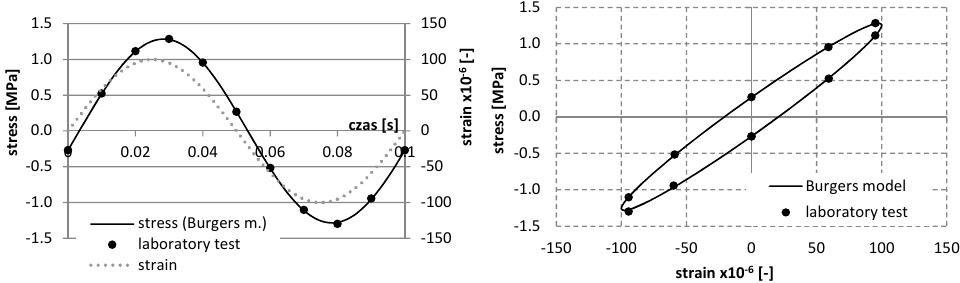
Figure 9. The results of laboratory study and the approximation of curves σ – ε using the Burgers model in the dynamic test at the temperature 10 °C (asphalt mixtures with an asphalt content of 4.5%).